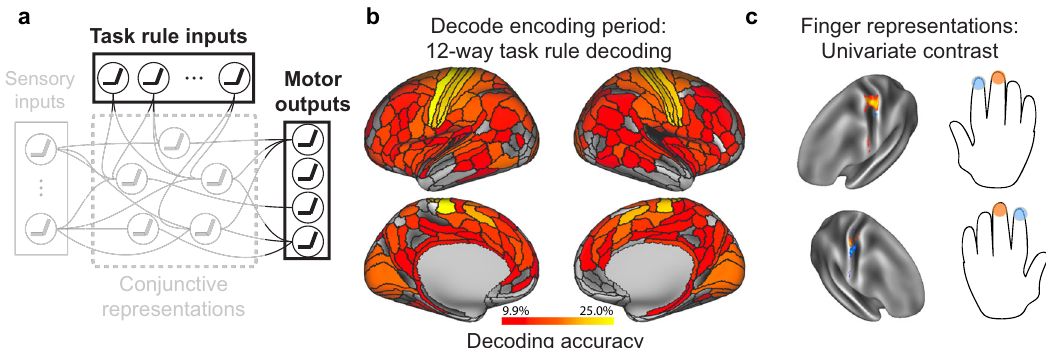
Fig. 4 Identifying ENN units (i.e., fMRI vertices) containing relevant task rule (context) and motor response (behavior) representations. a We identi fi ed the task rule input and motor output representations in empirical data using MVPA and univariate task activation contrasts. b A 12-way decoding of each of the task rules (across the 3 rule domains) using task activations (estimated from a task GLM) during the encoding period of the C-PRO task. We applied this 12-way decoding to every parcel, given that task rule activations have been previously shown to be widely distributed across cortex 8 . Chance decoding was 8.33%; statistical maps were thresholded using an FDR-corrected p < 0.05 threshold. c To identify the motor/output activations, we performed a univariate contrast, contrasting the middle versus index fi nger response activations for each hand separately. Finger response activations were estimated during the response period, and univariate contrasts were performed on a vertex-wise basis using all vertices within the somatomotor network 65 . Contrast maps were statistically thresholded using an FDR-corrected p < 0.05 threshold. The resulting fi nger activations matched the placement of fi nger representations in the well-established somatomotor homunculus in the human